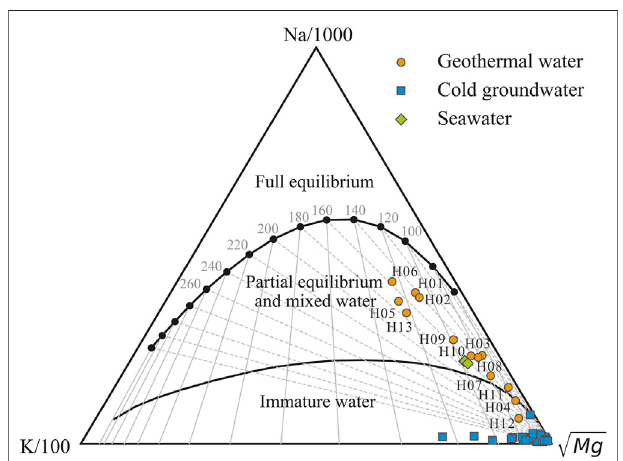
FIGURE 7 | Na-K-Mg ternary diagram of geothermal water samples in